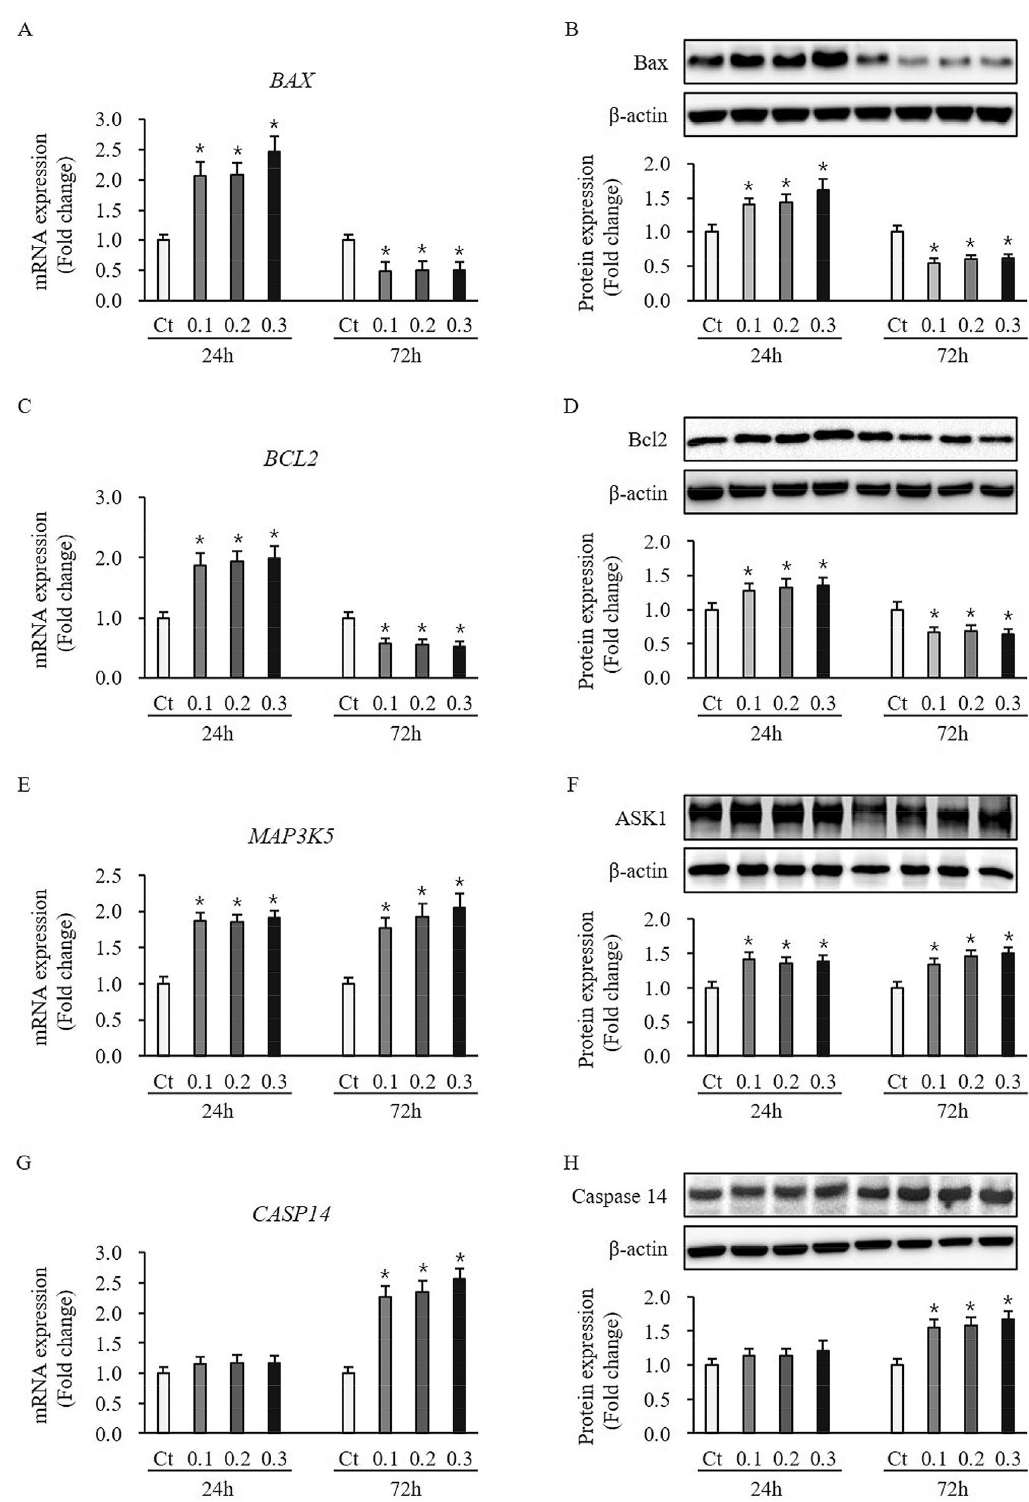
Figure 7. Expression of apoptosis-related factors in HTSKs. Significantly increased and decreased mRNA levels of bax ( BAX ) (A) and bcl2 ( BCL2 ) (C) in HTSKs at 24 h or 72 h after ESWT under 0.1, 0.2, and 0.3 mJ/mm 2 of energy flux density, comparted with those in untreated control. Significantly increased and decreased protein levels of bax (B) and bcl2 (D) in HTSKs at 24 h or 72 h after ESWT, comparted with those in untreated control. Significantly increased mRNA (E) and protein levels (F) of ASK1 ( MAP3K5 ) in HTSKs at 24 h or 72 h after ESWT, comparted with those in untreated control. Unchanged and significantly increased mRNA (G) and protein levels (H) of caspase 14 ( CASP14 ) in HTSKs at 24 h or 72 h after ESWT, comparted with those in untreated control. In the fold change, untreated control cells marked as value 1; Ct, untreated control cells; HTSK, hypertrophic scar keratinocyte; * P < 0.05 for ESWT-treated cells vs. the corresponding matched untreated control cells. Data represent means ± SD; n =